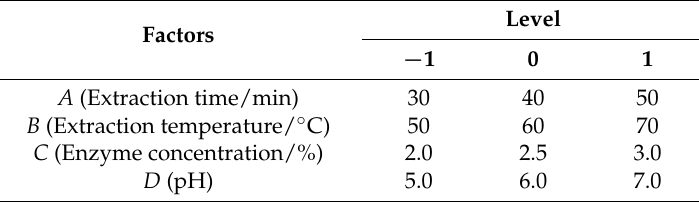
Table 1. Factors and levels of Box-Behnken experiment